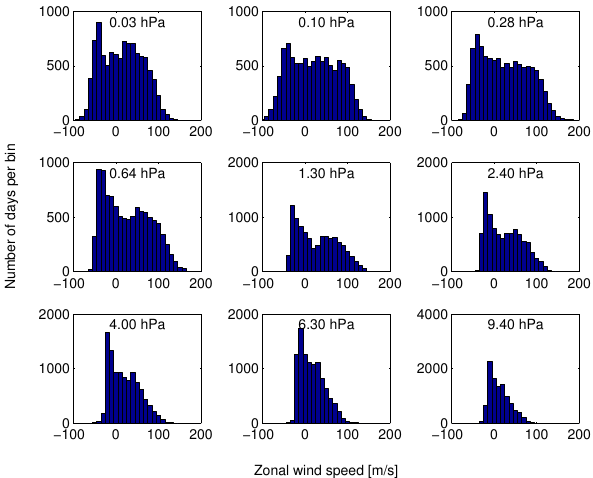
Figure 6. Distribution of zonal wind speeds on different altitude levels between 72km (top left panel) and 32km (bottom right) ac- cording to ECMWF operational analysis data. In this example 6 years of data for Bern have been used.